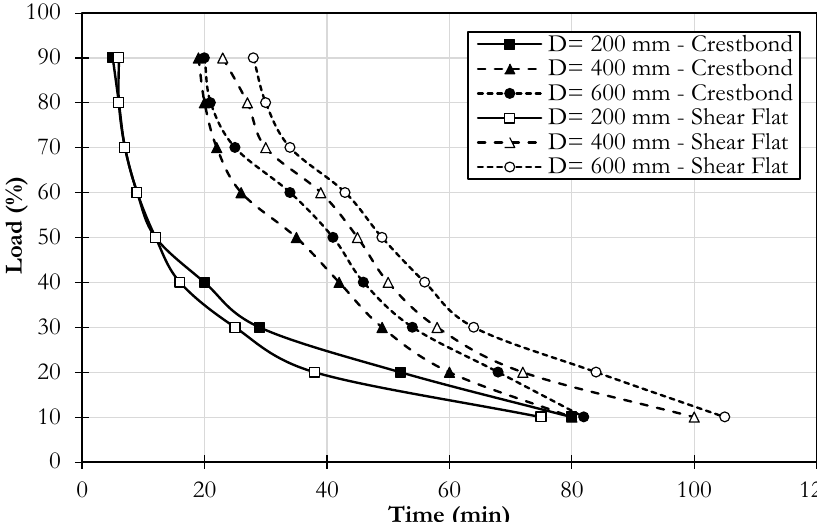
Figure 8. Time-load relationships obtained numerically for CFCC with load transfer